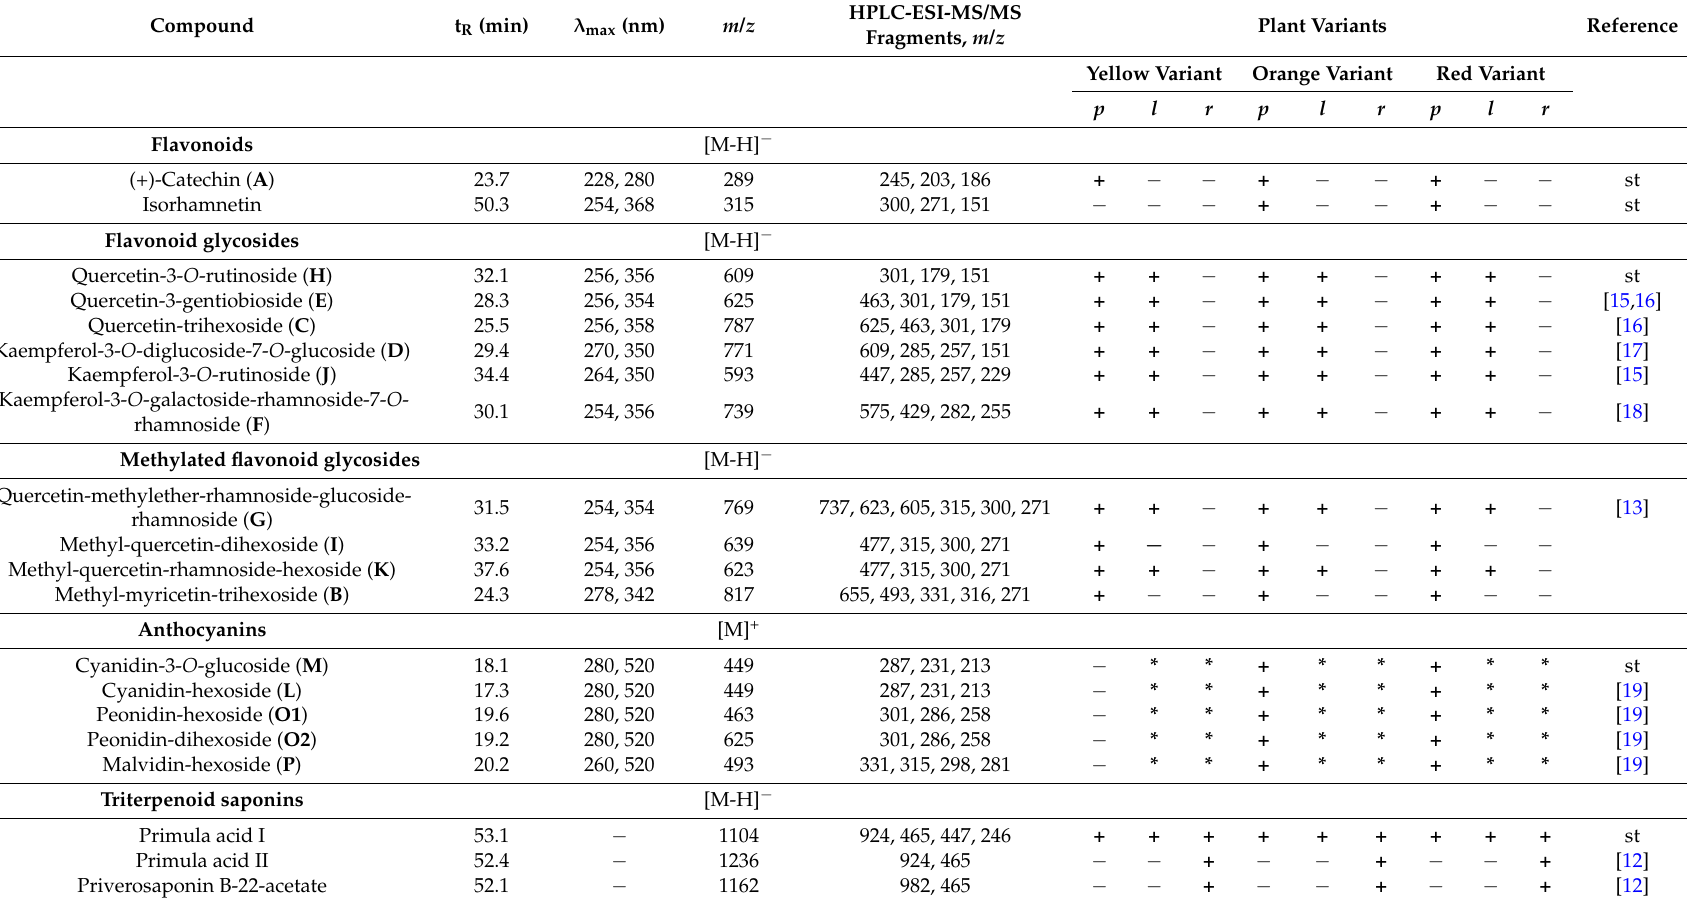
Table 1. Spectroscopic data (UV, MS) and HPLC retention times (t R ) of secondary metabolites from petal color variants of Primula veris